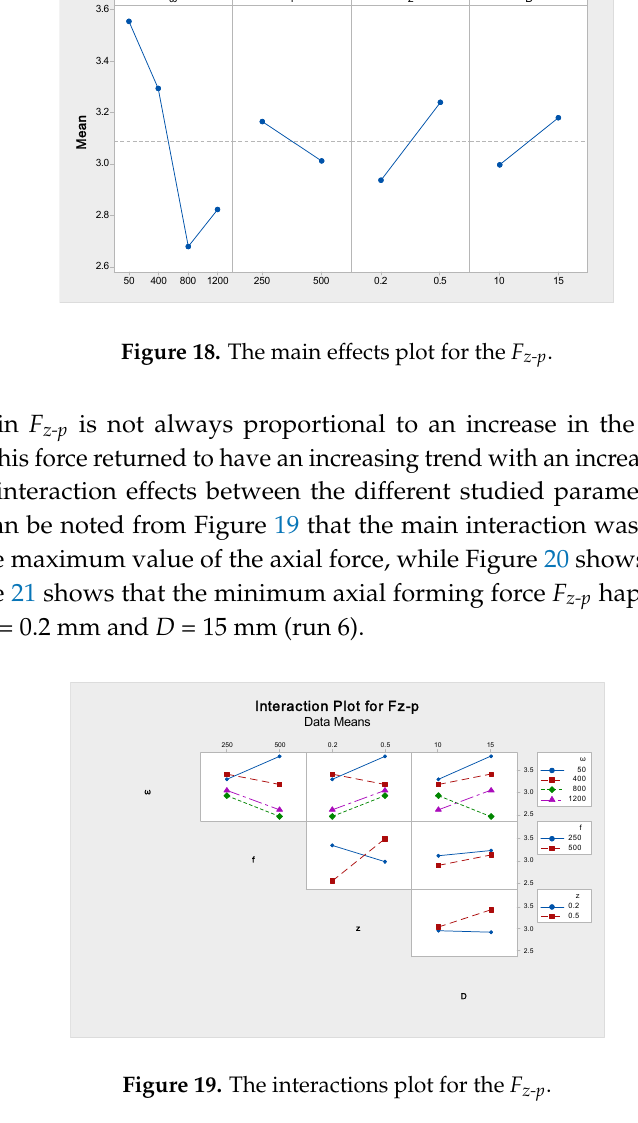
Figure 20. Surface plot of the F z-p against the feed rate and step size.